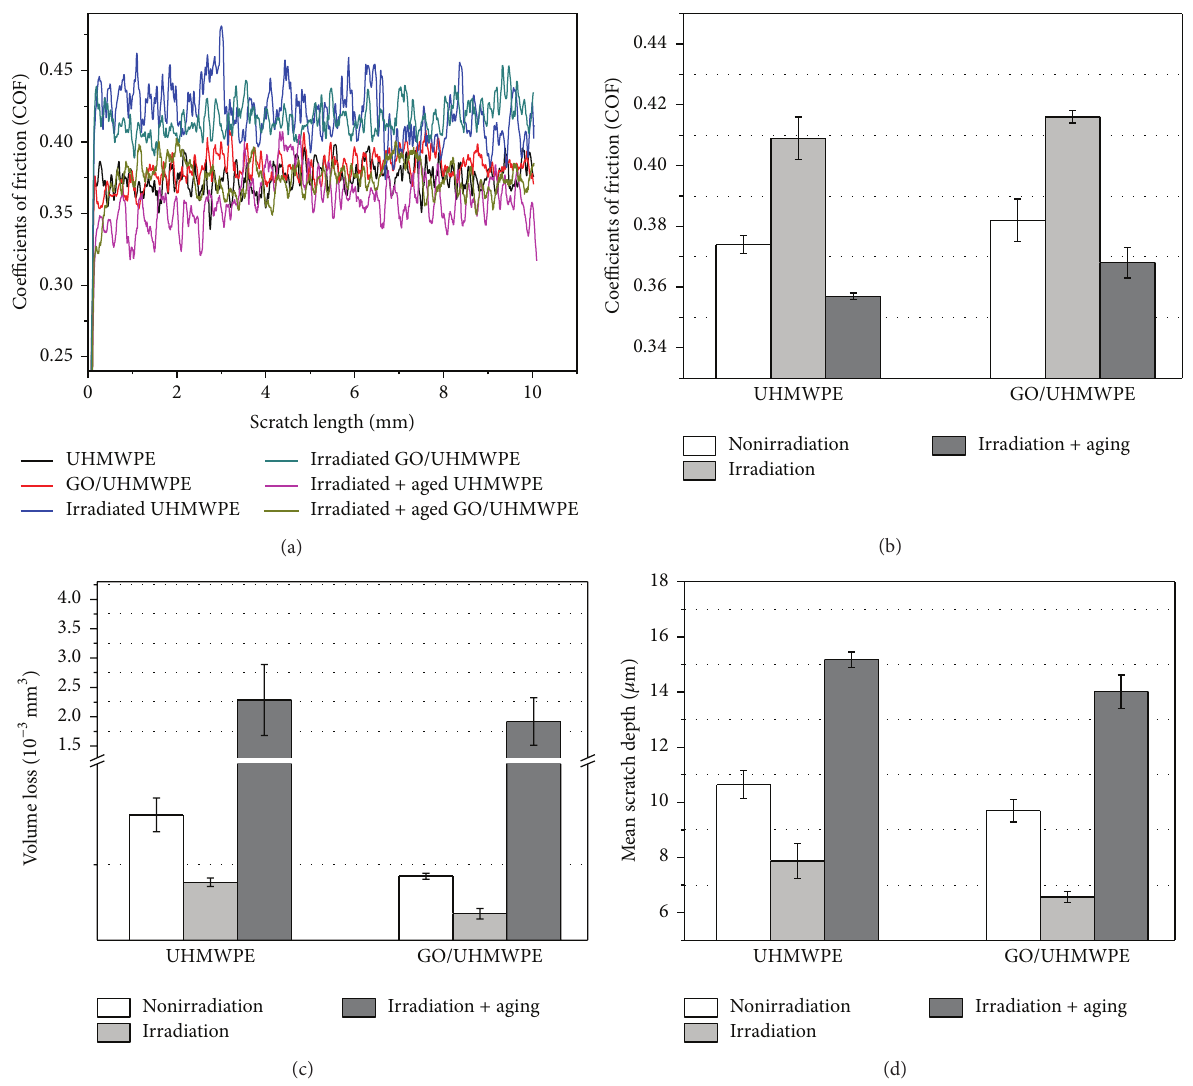
Figure 5: ((a), (b)) Coefficients of friction (COF) of test samples. (c) Wear rate of test samples. (d) Mean scratch depth.